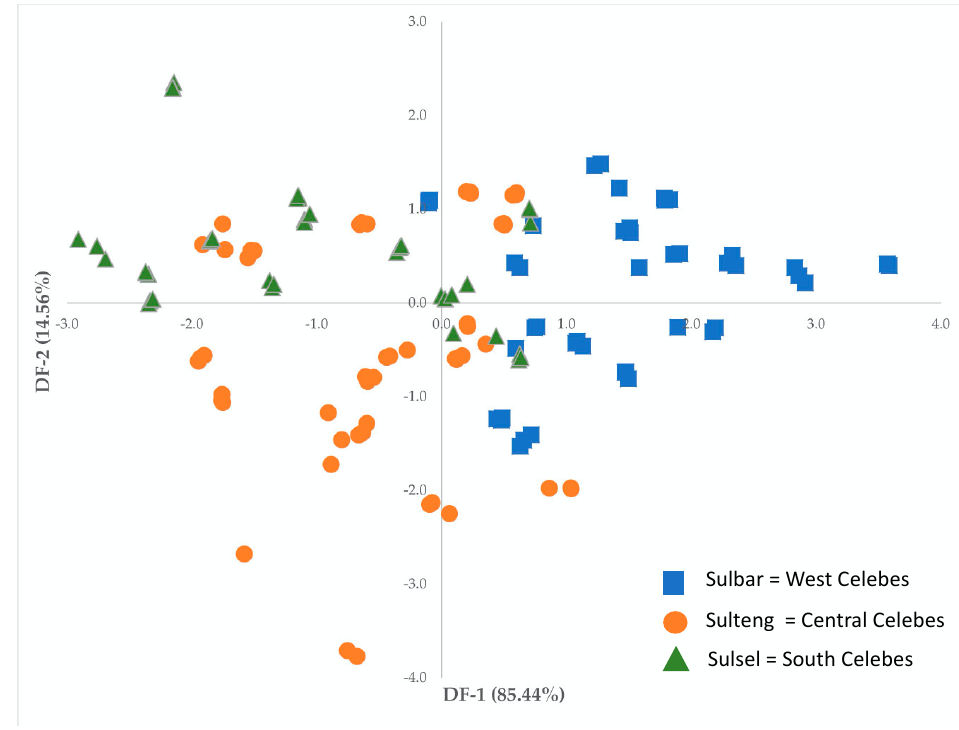
Figure 5. Discrimination ebony wood based on site origin using NIR spectra data processed by principal components analysis–discriminant analysis (PCA–DA).